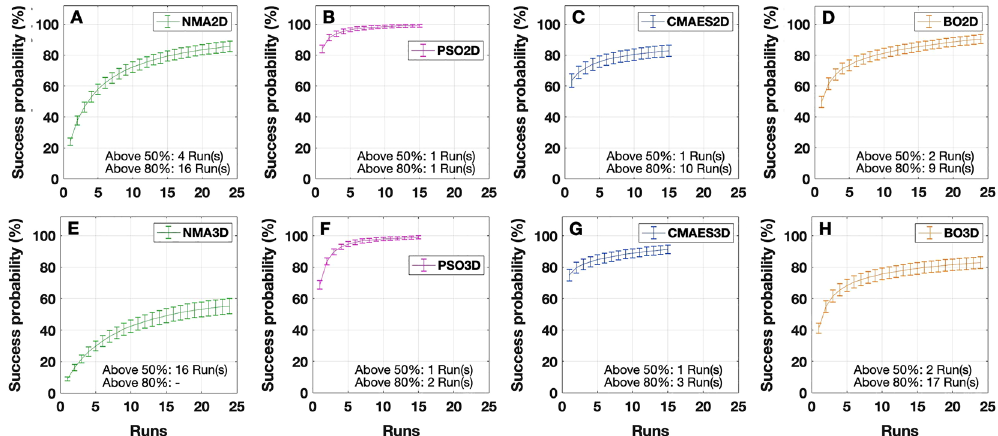
Figure 8. Numbers of algorithm executions and corresponding probabilities to obtain a goodness-of-fit not smaller than 95% of that from the grid search in the 2Dim ( A – D ) and 3Dim ( E – H ) cases. The probabilities were evaluated by randomly selecting R ∈ { 1, . . . , R max } goodness-of-fit values from the R max algorithm executions available for every subject ( R max = 15 for PSO and CMAES, R max = 24 for NMA and BO). A success was noted when at least one of the selected values was above or equal to the threshold. For every choice of R (i.e. the number of performed runs indicated on the horizontal axes), this procedure was repeated 500 times. The results were then averaged across all subjects in order to obtain the mean success probabilities indicated on the vertical axes. For the optimization methods presented in the legends (same notations as before), the plots illustrate the mentioned success probabilities together with the respective standard error (error bars). Additionally, it is indicated after how many runs success probabilities of 50% and 80% could be surpassed. The figure was created with MATLAB R2018a (www. mathw orks. com).